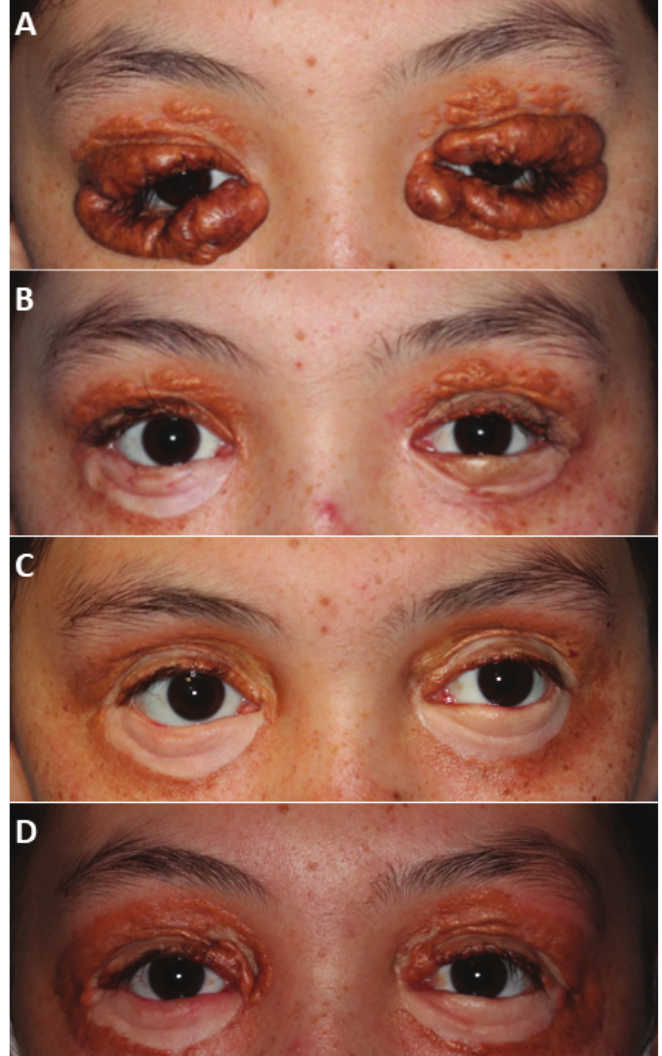
Figure 2. Periorbital lesions preoperatively (A) compared to status post-surgical excision and intralesional steroid application (B). (C) Postoperative month three after CO laser resurfacing. (D) Demonstration of persistent regression of lesions 39 months 2 postoperatively, with only mild